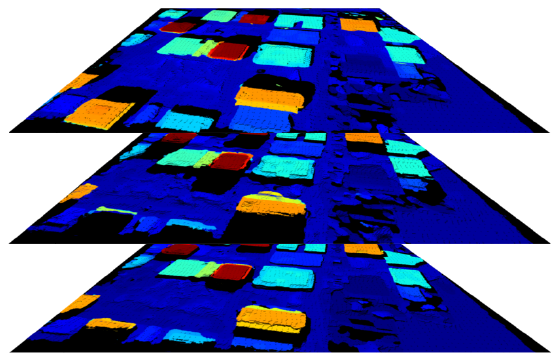
Figure 1: Fusion of multiple DSMs covering the same area Another direction of work (Pock et al., 2011) aims to formulate a global energy function, minimizing the distance of the fused result to all input DSMs simultaneously and additionally incor- porates the assumption of the world being locally planar. Due to its simple structure and theoretically well founded minimization procedure, we build upon this work and extend it to a weighted, multi-resolution, fusion